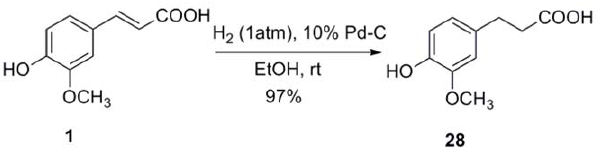
Figure 7. Synthesis of compound 28.